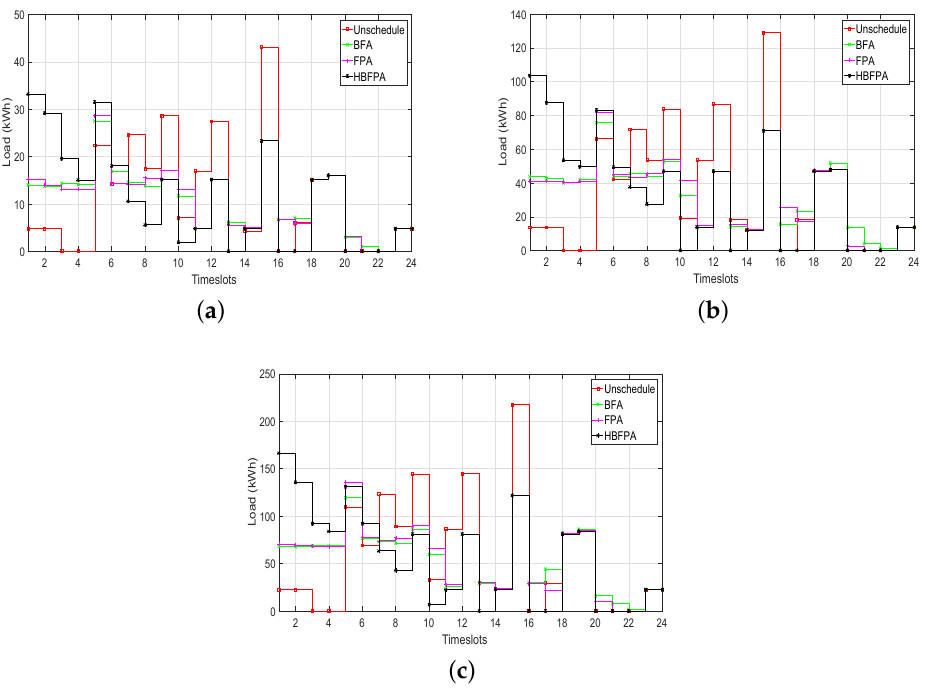
Figure 12. Load for multiple homes: (10, 30 and 50) using critical peak pricing. ( a ) load using operational time interval of 60 min for 10 homes; ( b ) load using operational time interval of 60 min for 30 homes; ( c ) load using operational time interval of 60 min for 50